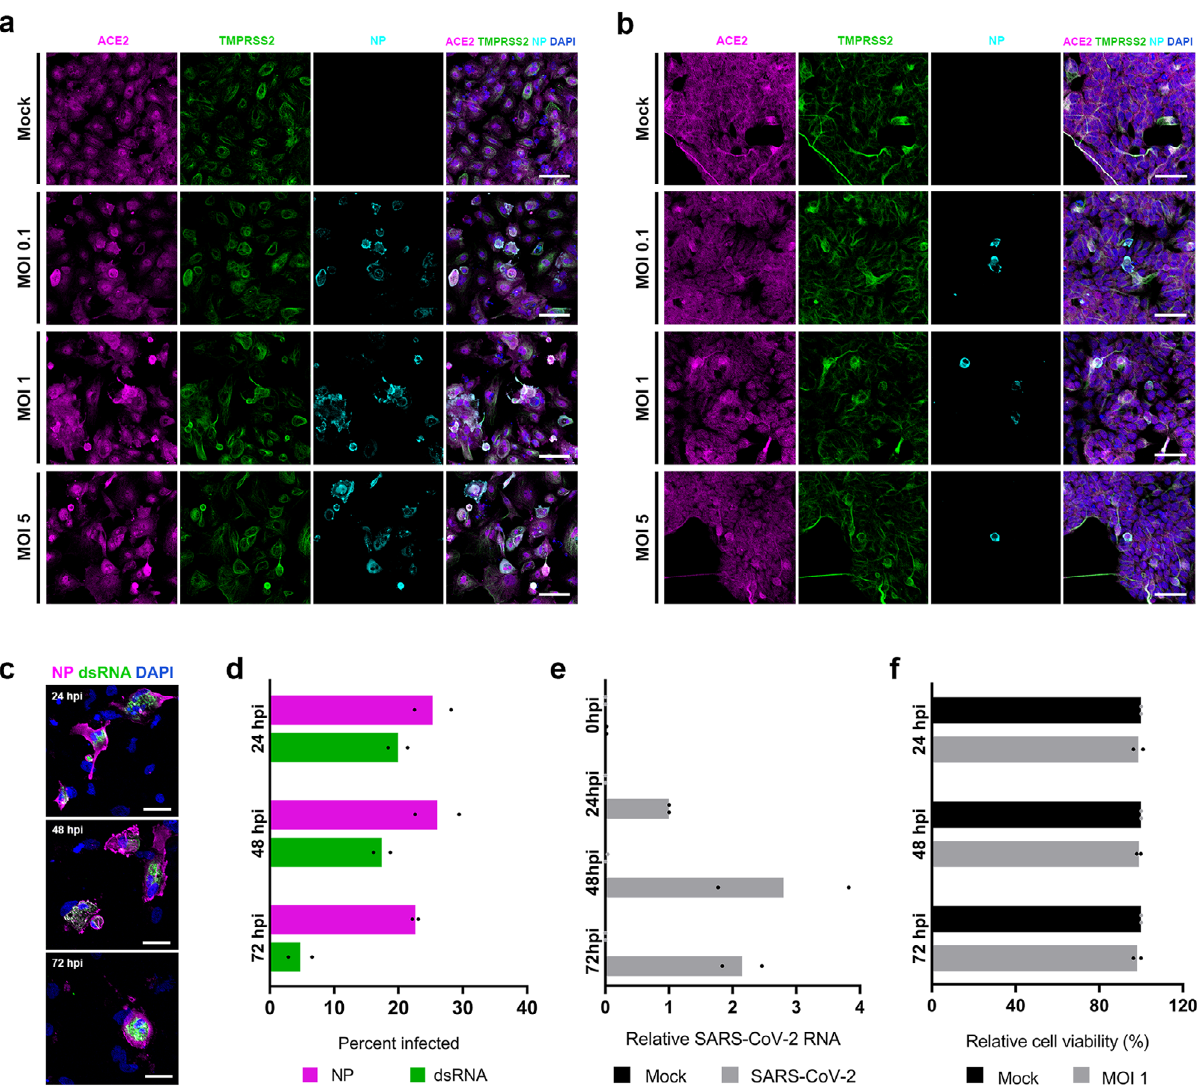
Fig. 4 SARS-CoV-2 infection of OPCs and SCPs generated from hiPSC. a Infected OPCs differentiated from hiPSC line UCSD112i-2-11 were visualized by immunostaining for viral nucleoprotein (NP) and co-immunostaining for ACE2 and TMPRSS2 at 48 hpi. Representative images from 4 independent experiments with similar results. Scale bars = 100 μ m. b Infected SCPs differentiated from hiPSC line SK8-A are visualized by immunostaining for viral NP and co-immunostaining for ACE2 and TMPRSS2. Note that these images are chosen to show infected cells and are not representative fi elds of the overall culture of cells. Similar results were seen in 2 biological replicates each with 2 nested technical replicates. Scale bars = 50 μ m. c SARS-CoV-2 NP and dsRNA stained with the J2 antibody were detectable in infected OPCs at MOI 1 at 24, 48, and 72 hpi. Data are representative images from 2 independent infections. Scale bars = 50 μ m. d Quanti fi cation of data shown in ( c ). Mean percentages of infected OPCs are plotted as detected by immunostaining with either anti-NP or J2 antibody at 24, 48, and 72 hpi. Points represent the mean value from each of two independent experiments ( N = 2, each with 3 nested replicates). MOI = 1. e Mean fold change of SARS-CoV-2 RNA in the supernatant of OPCs compared to 24 hpi samples in each experiment (MOI = 1). Except for the zero hour sample, samples harvested at each time point represent viral RNA released over previous 24 h only. Bar height represents geometric mean of two experiments, each with two nested replicates. Points represent the mean value from each of two independent experiments ( N = 2, each with 2 nested replicates). Normalization to a cell-associated housekeeping gene RNA was not performed. f OPC cell viability was measured using a bioluminescence assay for ATP. Mean relative light units (RLU) for each sample is plotted as a percentage of RLU in the equivalent mock-infected sample at 24, 48, and 72 hpi. N = 2, 3 technical replicates. OPC infections were performed at a MOI of